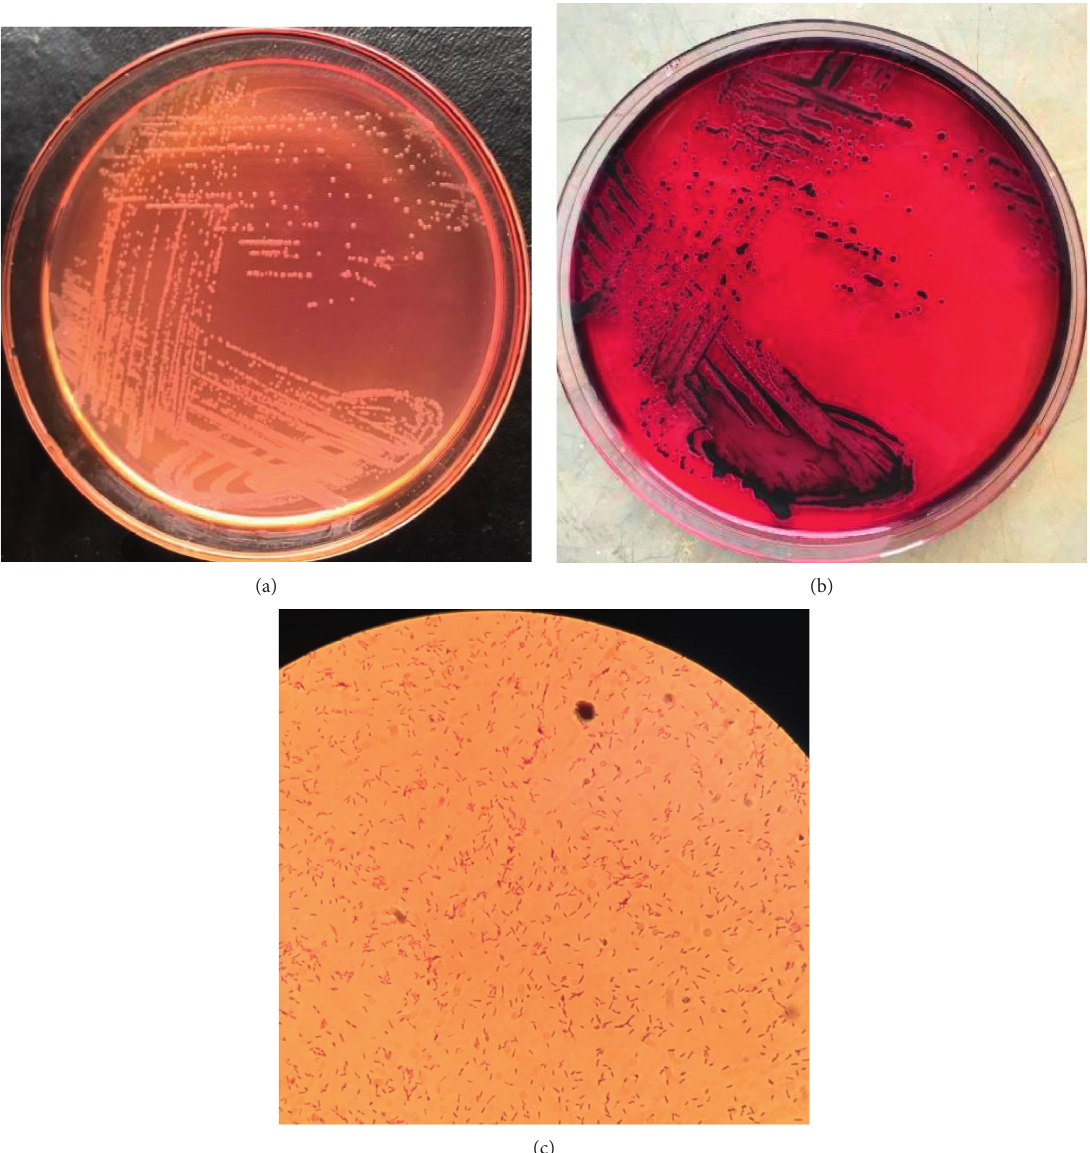
Figure 1: (a): Salmonella gallinarum colonies in MacConkey agar. (b) Salmonella gallinarum colonies in xylose lysine deoxycholate (XLD) agar. (c) Rod shaped of Salmonella gallinarum ( × 100) after Gram staining. Table 3: Percentage of chickens with Salmonella spp. identified by microscopical and biochemical tests from both wards.